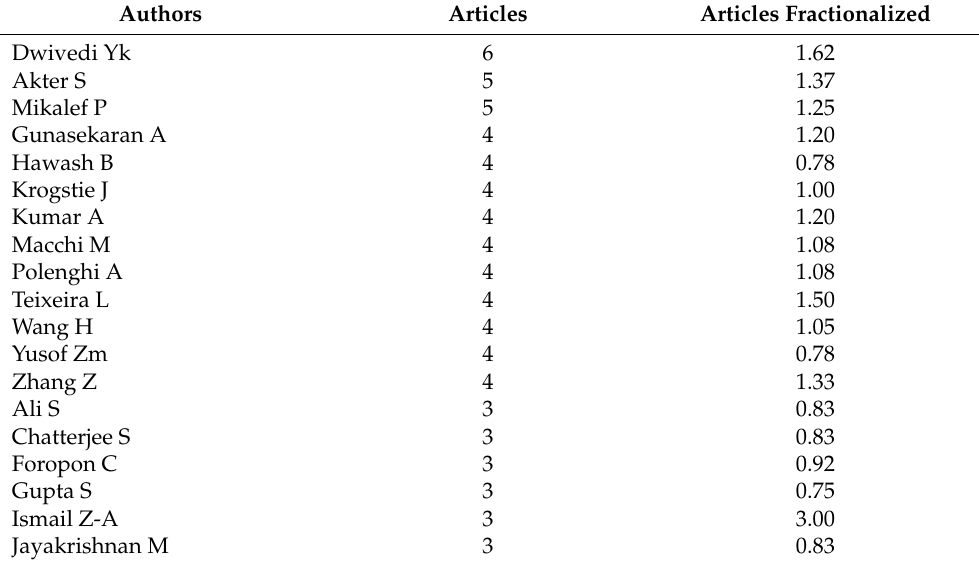
Table 5. Most impactful